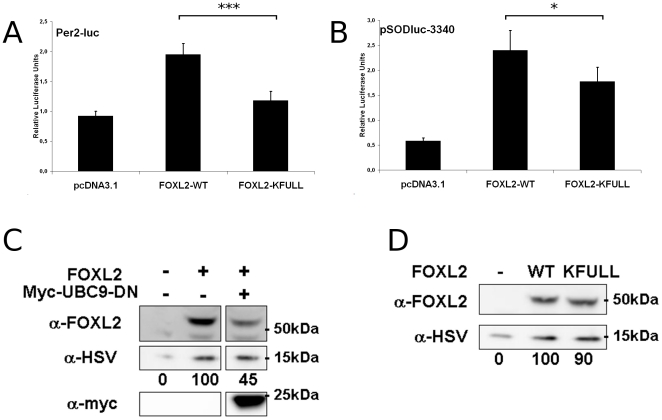
Enhanced stabilisation of FOXL2 partially explains the transcriptional effect of SUMOylation.A and B) Luciferase assays in KGN cells transfected with Per2-luc and pSODluc-3340 (40 ng/well), respectively, with or without FOXL2-WT or FOXL2-KFULL overexpression (20 ng/well). Each value is representative of six biological replicates. Error bars represent the SEM. Statistical significance in Student t-tests: n.s.: non-significant, *: p<0.05, **: p<0.01, ***: p<0.001 C) Western blot of whole cell extracts of KGN cells transfected with or without FOXL2-V5 and myc-UBC9-DN (each 1 ug/well in a 6 well plate), using pcDNA3.1 as a mock vector. Lic- (expressing a fusion protein His-Tag∶S-Tag∶HSV-Tag∶His-Tag) was used as an internal transfection control (500 ng/well). First panel: FOXL2. Second panel: Lic- (anti-HSV). Third panel: UBC9-DN (anti-myc). Below second panel is indicated the relative intensity of the FOXL2 band compared to the Lic- band. D) Western blot of whole cell extracts of KGN cells transfected for 24 h with or without FOXL2-WT-V5 or FOXL2-KFULL-V5 (2 µg/well in a 6-well plate). Lic- (500 ng) was used as a transfection control. First panel: FOXL2. Second panel: Lic- (anti-HSV). Below second panel is indicated the relative intensity of the FOXL2 band compared to the Lic- band. All experiments were repeated at least three times with consistent results.